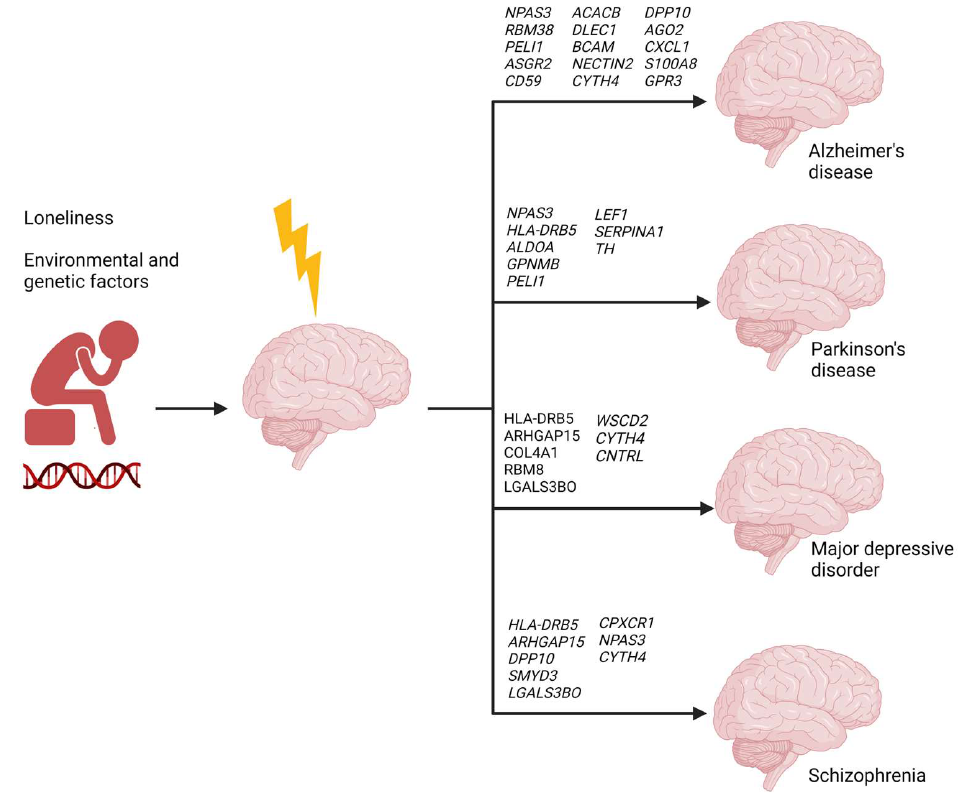
Figure 5. The impact of loneliness on brain health. Loneliness, social isolation, environmental stressors, and genetic factors can have detrimental effects on the brain and may lead to several neuropsychiatric and neurodegenerative diseases. Several switch genes responsible for the dramatic transcriptional changes in the brains of lonely individuals have been reported to play a role in the pathogenesis of neuropsychiatric and neurodegenerative diseases.